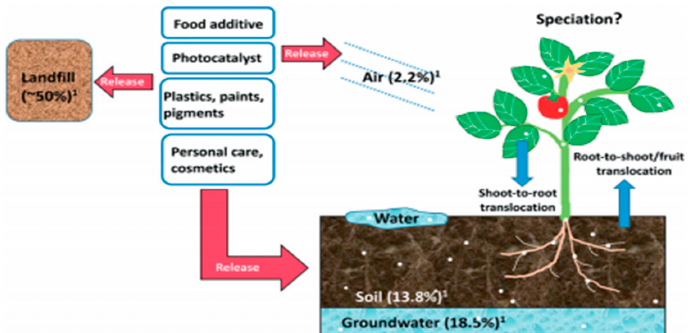
Figure 8. Uses and dispersion of TiO 2 NPs into the environment and interaction with plants. Adapted with permission from [107]. Copyright, 2018 The Royal Society of Chemistry. After the entry of TiO 2 NPs via several pathways, soil properties—such as soil en- zymes, microbial communities, nutritional elements, and pH—affect their behavior, mo- bility, and bioavailability, thereby determining the fate of TiO 2 NPs. The interconnected soil properties/factors, such as soil type, pH, ionic strength, and organic matter, affect the transport of TiO 2 NPs by changing their zeta potential, aggregation, surface charge, and van der Waals force [108,109]. The existence of microbes in the soil is vitally important for the decomposition and recycling of organic material. As a result, TiO 2 NPs may alter the microbial population, diversity, and activity by changing the soil properties [103,110]. Low concentrations of TiO 2 NPs also increase urea activity [111]. On the other hand, at extremely higher concentrations (1000 mg/L), TiO 2 NPs decrease urea activity [112,113], affect the level of bacterial nitrogen, and reduce catalase, phosphatase, invertase, and pe- roxidase activities [103]. Reports suggests that TiO 2 NPs also disrupt the gene expression of bacteria, resulting in decreasing nitrogen fixation and methane oxidation, which are essential for the decomposition of proteins and organic pollutants [81]. The interaction between plants and TiO 2 NPs depends on their particle size, crystal phase, and surface coating [107]. Smaller TiO 2 NPs (less than 30 nm) can enter into plant cells by reducing the size of the pores and the flow of water in corn [114] and wheat [115]. Investigations show that TiO 2 NPs of 12, 22, and 25 nm can be translocated from the roots to the leaves [115]. The antioxidant stress is interrupted by TiO 2 NPs in duckweed [116] and tomato [117]. TiO 2 NPs also interrupt different parameters in raceme elm [118], onion [119], soybean [120], rice, spinach [121], and parsley [122]. As TiO 2 NPs show photocata- lytic activity under light irradiation, they can alter photosynthesis, metabolism, and gene expression within plants. Some investigations reported negative effects caused by TiO 2 NPs on plant growth, whereas it was concluded that TiO 2 NPs may cause some sensitive plant growth-promoting bacteria to disappear from soil. Accordingly, such impairment of the soil bacterial community composition may further affect ecosystem functioning [123,124]. 5.2. TiO 2 NPs in the Aquatic Environment The significantly increased leakage of TiO 2 NPs into surface and marine water envi- ronments has a great impact on aquatic ecosystems. The related studies have been mainly concentrated in determining the behavior of TiO 2 NP in marine environments, focusing mostly on marine plankton and benthos, with comparable contribution of papers, i.e., 42.1% and 44.7%, respectively, as well as in marine fish, with the smallest share of the research, i.e., 13.2% [125]. As TiO 2 NPs are very reactive, they follow different transfor- mation processes when they are released into the aquatic ecosystem. These transformation